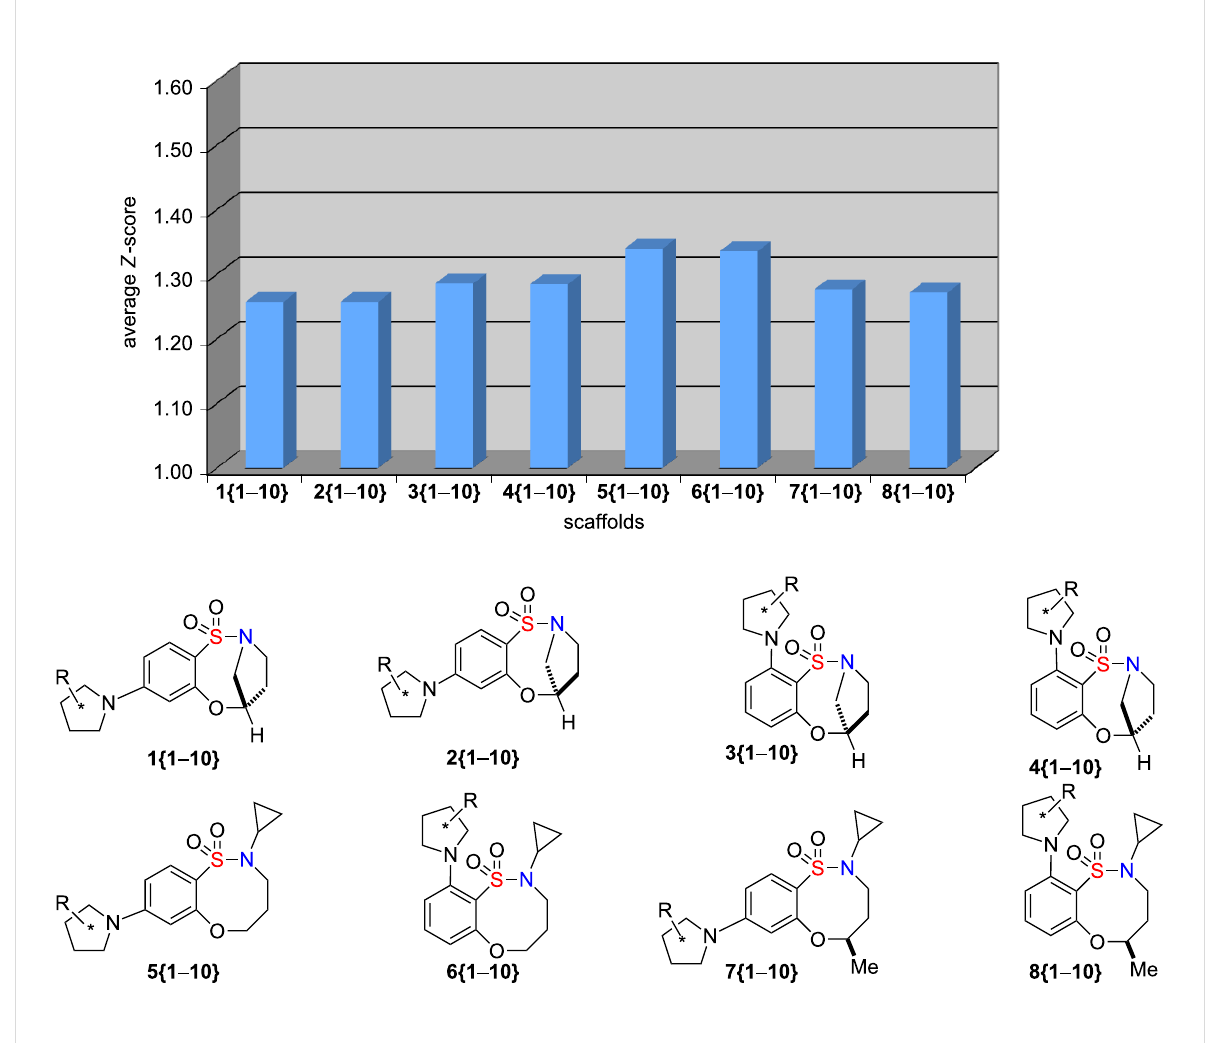
Figure 7: Representation of Z -scores for the 80